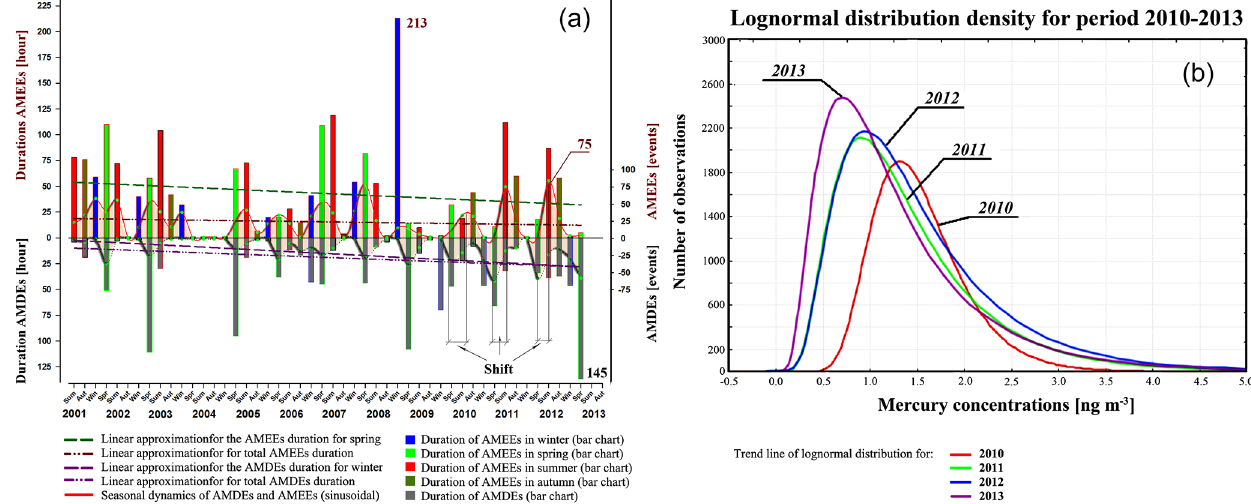
Figure 14. (a) Seasonal dynamics of AMDEs and AMEEs during the monitoring period from 2001 to 2013 (sinusoidal area). Duration of AMDEs and AMEEs (bar chart – red, summer; green, spring; dark yellow, autumn; blue, winter). Linear approximation for the AMEE duration for spring (green dashed line), AMDE duration for winter (purple dashed line), total AMEE duration (brown dash with two dots), and total AMDE duration (purple dash with two dots). (b) The lognormal distribution of the atmospheric Hg 0 concentration during the monitoring period from June 2010 to October 2013.